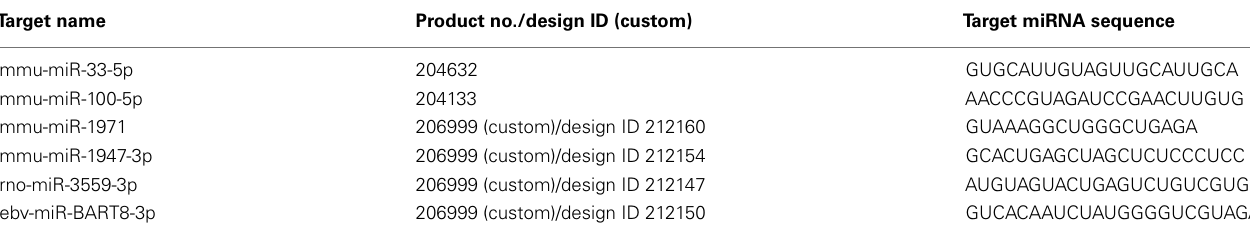
Table 1 | List of primer sets used for